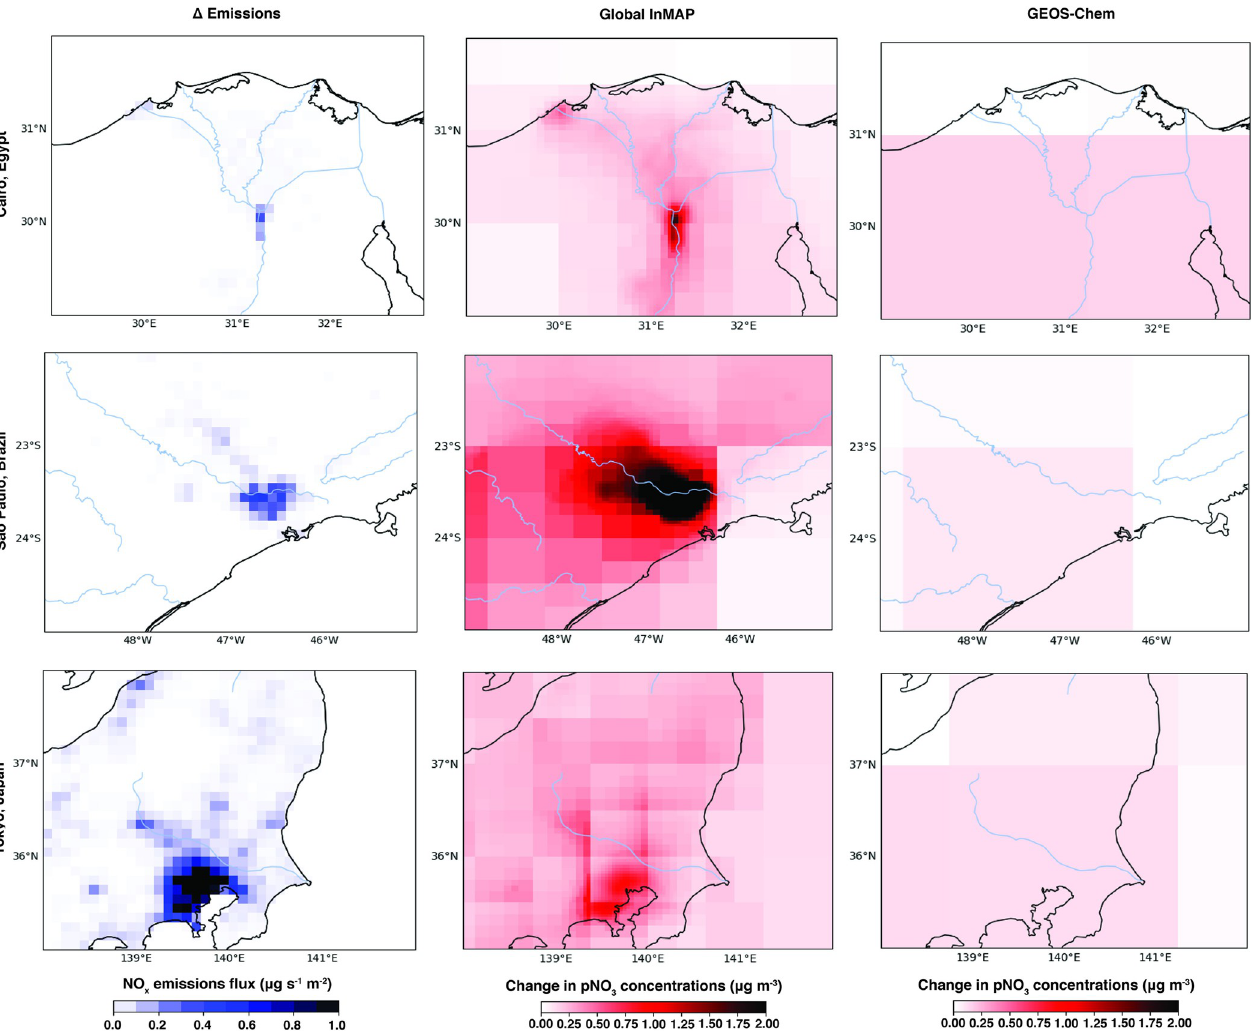
Fig 14. First column : 100% increase in NO x emissions from road transport across Cairo, S ã o Paulo, and Tokyo. Second and third column : Resulting changes in pNO 3 concentrations predicted by the Global InMAP and the GEOS-Chem simulations. For each map, blue lines indicate rivers and black lines indicate land borders.